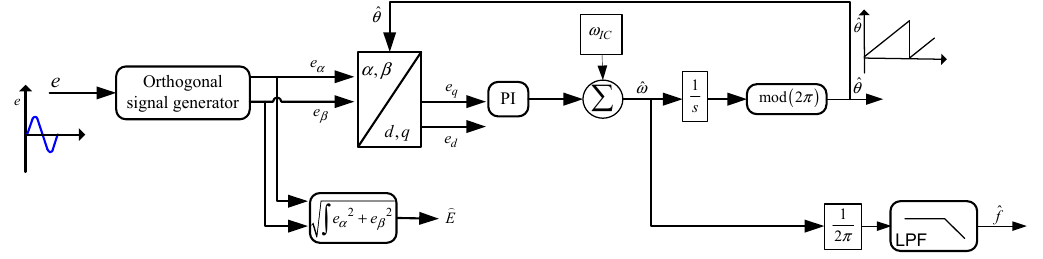
Figure 4. Phase-locked loop (PLL) structure based on the Park transform.